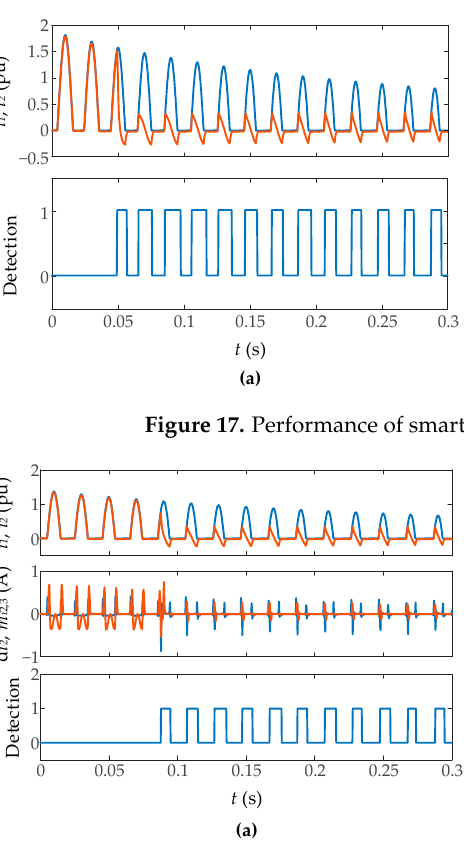
Figure 16. Experimental setup for real time test.